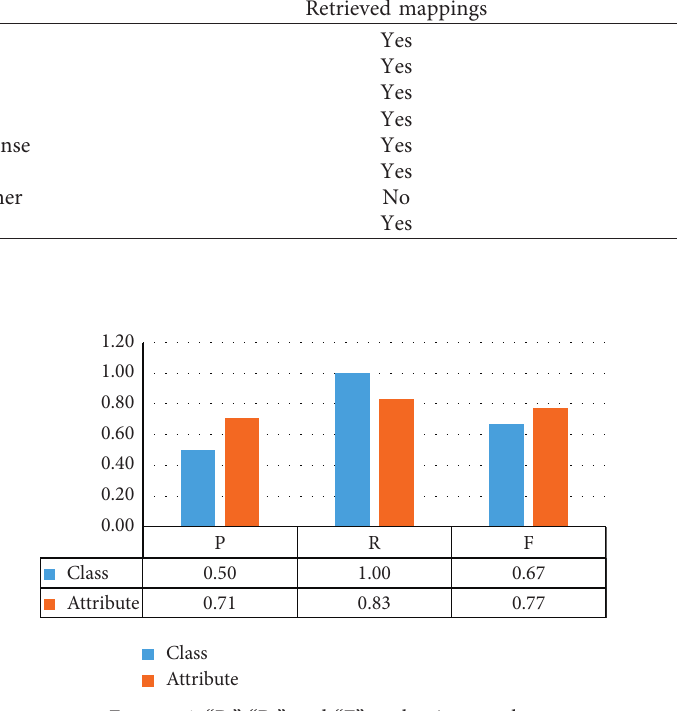
Figure 6: “P,” “R,” and “F” evaluation results.